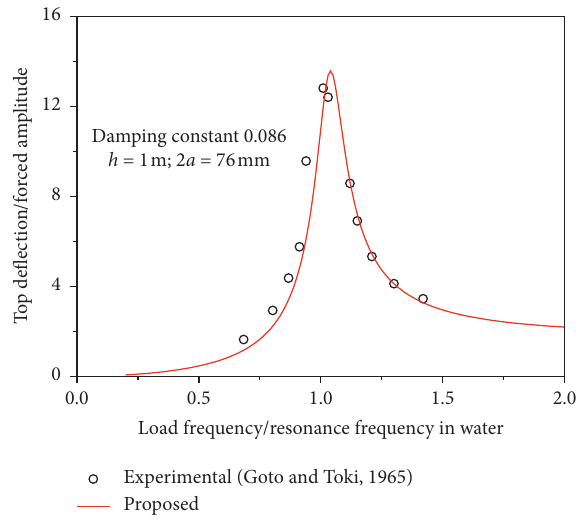
Figure 6: Resonance curve of a circular cylinder excited by har- monic ground motions.